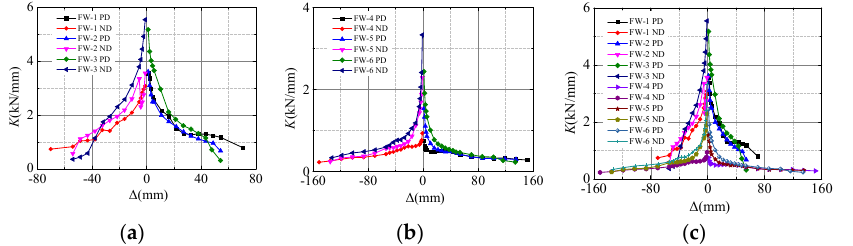
Figure 15. Stiffness degradation: ( a ) Specimens with rigid bracings; ( b ) Specimens with flexible bracings; ( c ) Comparison of all specimens.